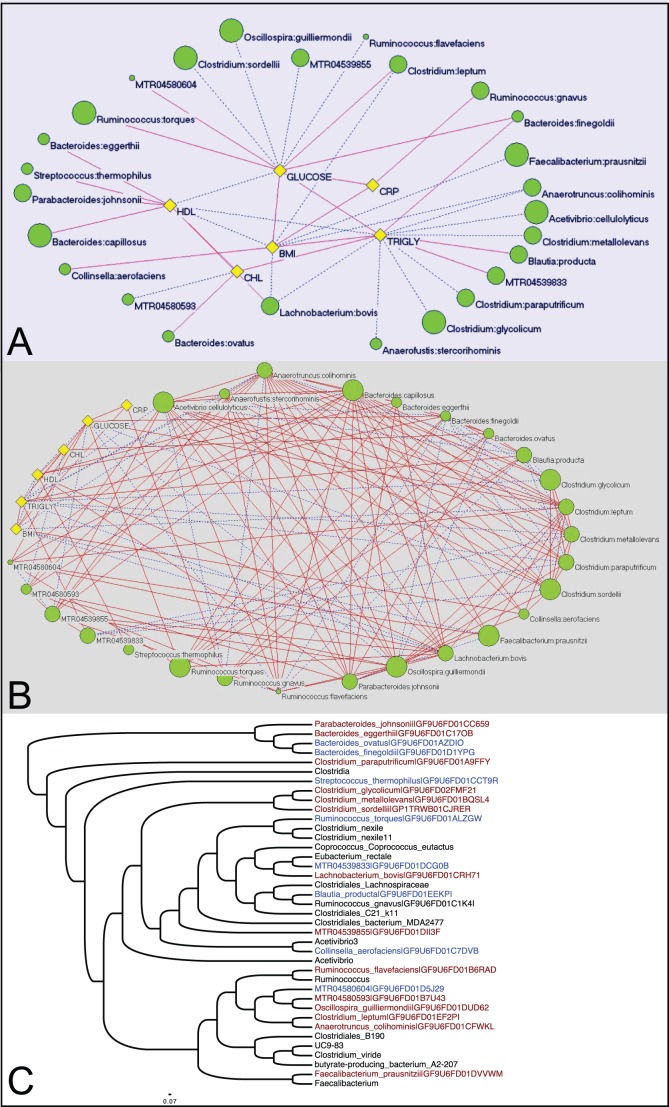
Bacterial species and OTUs correlated with metabolic syndrome phenotype.(A) Known species and Operational Taxonomic Units (OTUs) (green circles) linked to metabolic syndrome traits (yellow diamonds), illustrating statistically significant correlation coefficients using the Louvain algorithm. The size of the circles represents the mean relative abundance in the Amish cohort studied. Numbers connecting microbes are the correlation coefficient (p<0.001 for all). Solid lines represent positive correlations and dashed lines represent inverse correlations. (B) The same network as shown in panel A, but also including the statistically significant associations between bacterial taxa. (C) Phylogenetic tree of 16S rRNA sequences from the bacterial taxa in this network using the R implementation of DNADIST and FASTME. OTUs and known species that are inversely correlated with metabolic syndrome traits are colored in red and that are positively correlated with metabolic syndrome traits are colored in blue (p<0.001 for all).